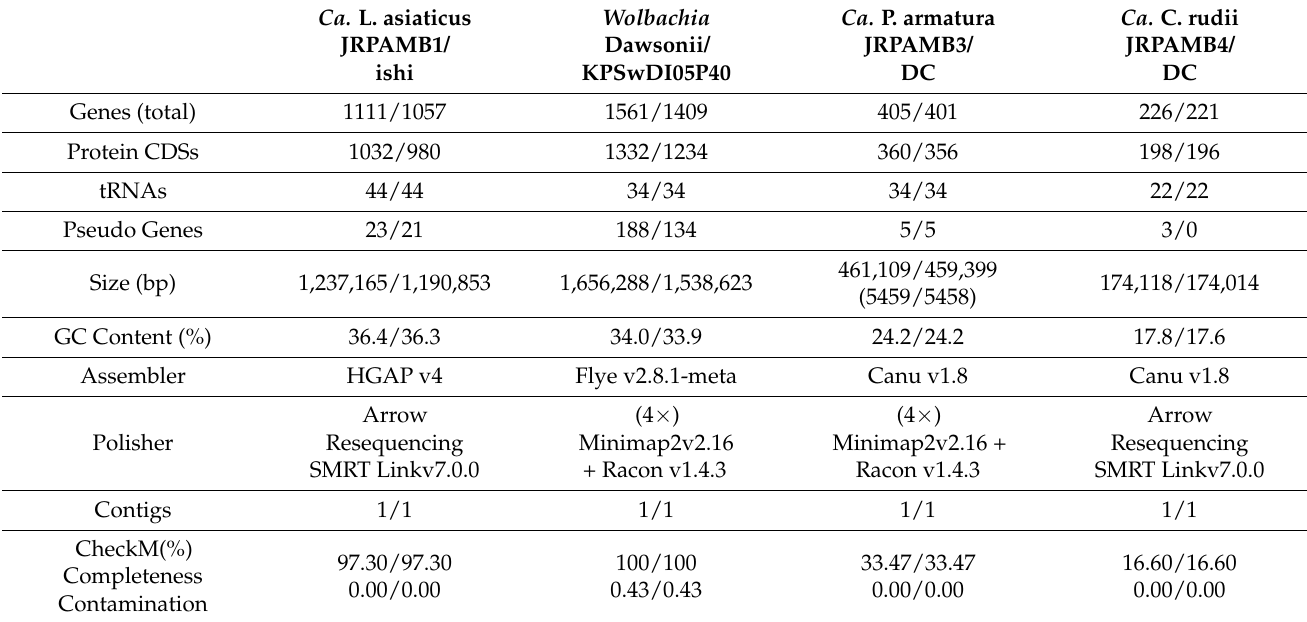
Table 1. Assembly statistics comparing the NCBI PGAP annotations of this publication to the closest strains deposited to NCBI sharing the highest nucleotide similarity. From left to right for NCBI strains: Ca. L. asiaticus str. ishi, Wolbachia KPSwDI05P40, Ca. P. armatura str. DC, Ca. C. ruddii str. DC. The size reported in parentheses for Ca. P. armatura reflects the length of the